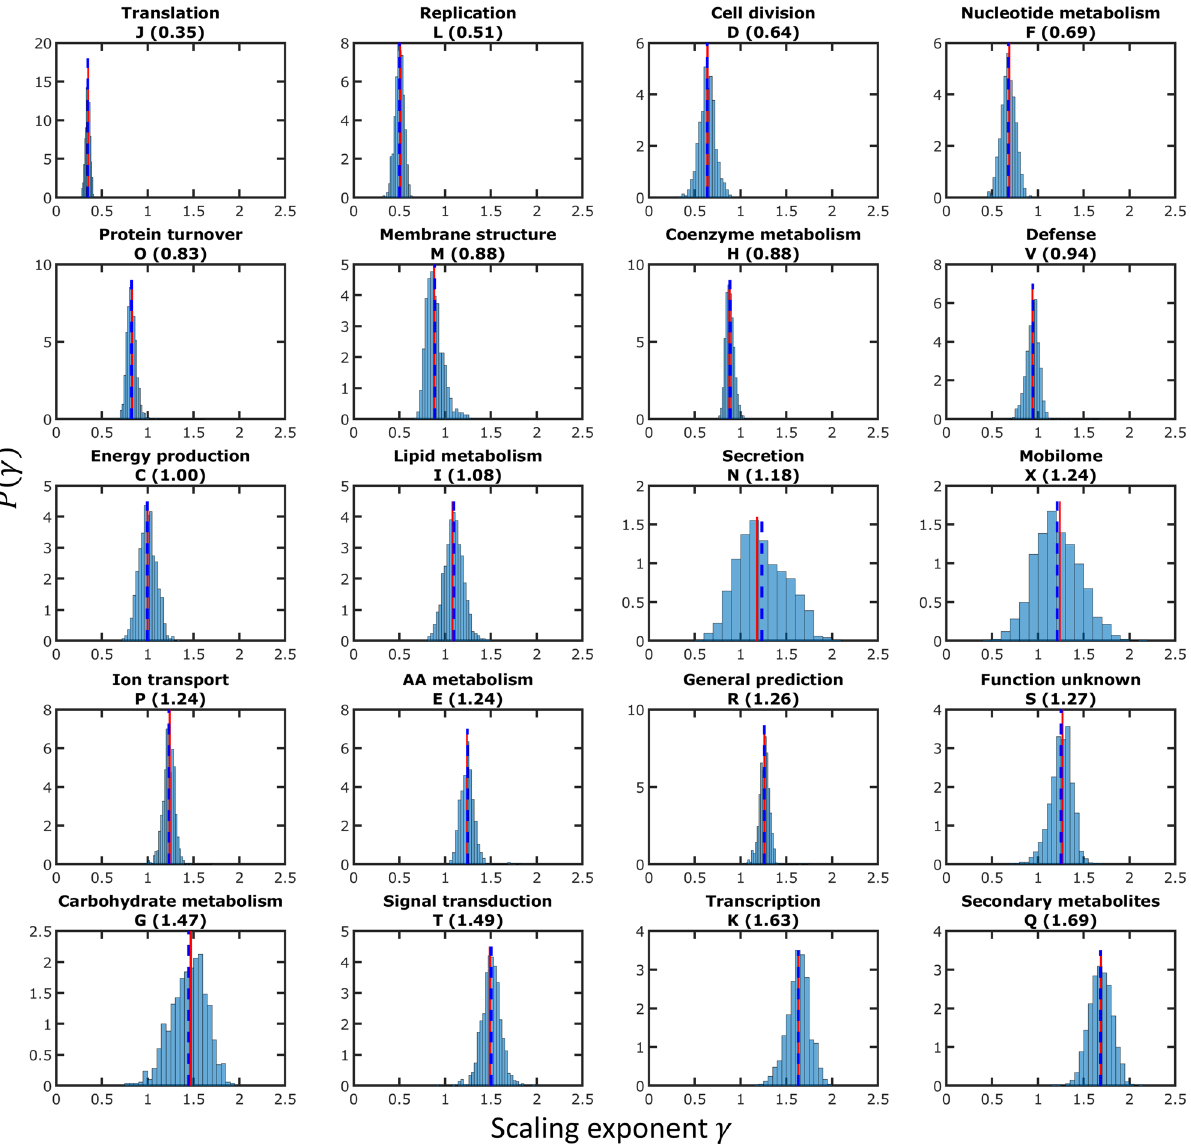
FIG. 4. Statistical support for scaling exponents calculated using bootstrap analysis. The distribution of fitted scaling exponents is shown for each class, for 1000 bootstrap samplings (see Appendix C). The mean of the distributions is indicated by a vertical dashed blue line, and the fitted scaling exponent for the original dataset is indicated by a vertical solid red